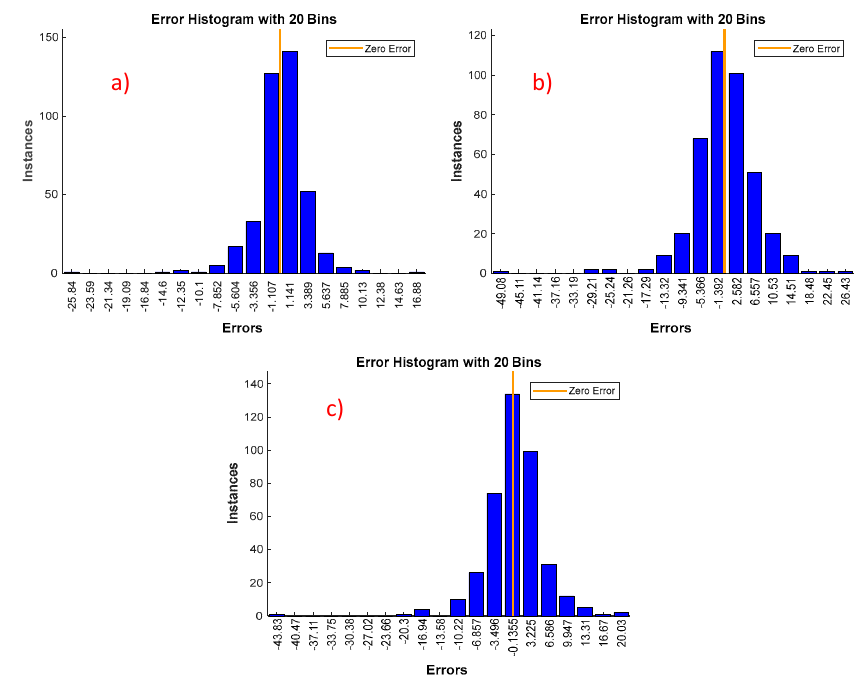
Figure 6. Error Histogram ( a ) with all features; ( b ) CFS feature selection technique; ( c ) ReliefF feature selection technique for training and validation.